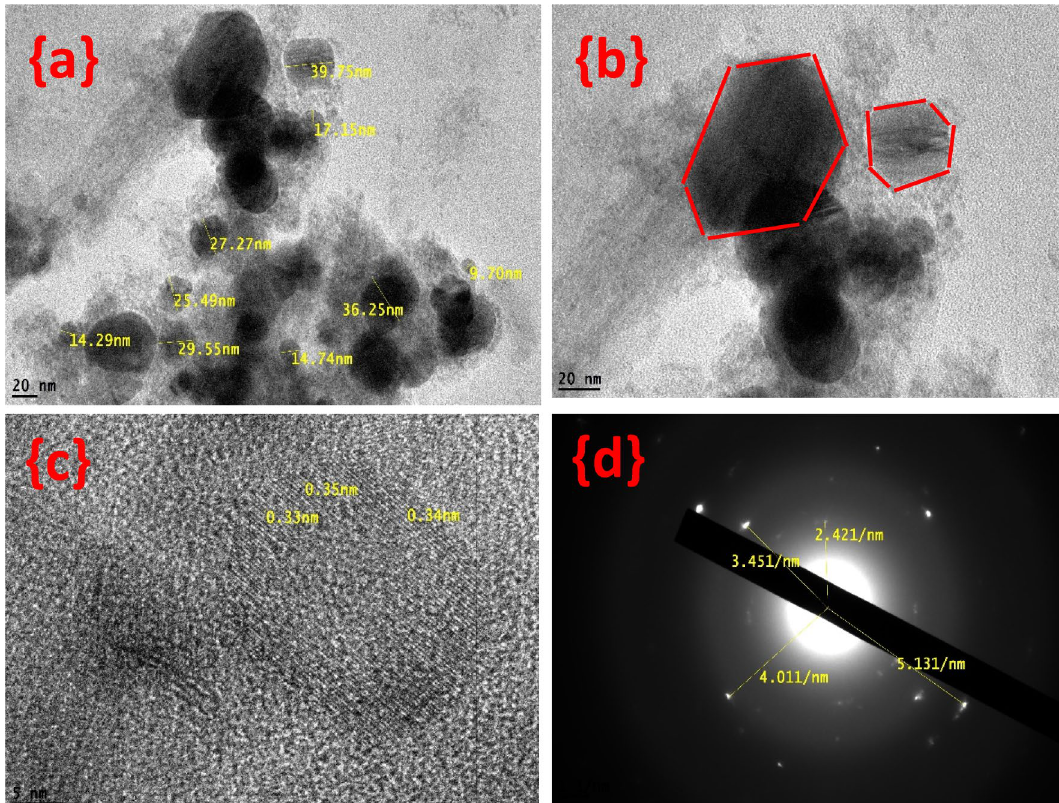
Figure 4. HRTEM images of copper hydroxide at different magnifications ( a , b ) and the SAED ( c , d ).